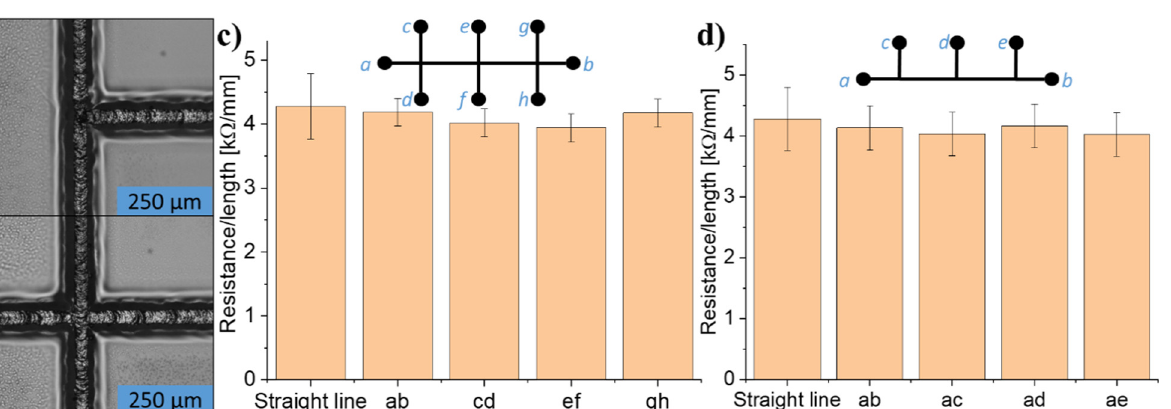
Figure 12. ( a , b ) show the joining and intersecting of two laser-pyrolyzed lines. The vertical lines are written first, the horizontal lines are written second. ( c , d ) show resistance per path length measured between the points shown on the schematic insets compared to the resistance of a straight line written with the same parameters. All lines were written at 80 mW power, 0.1 mm/s scan speed, using two scans. The error bars are based on the standard deviation ( n ≥ 3).